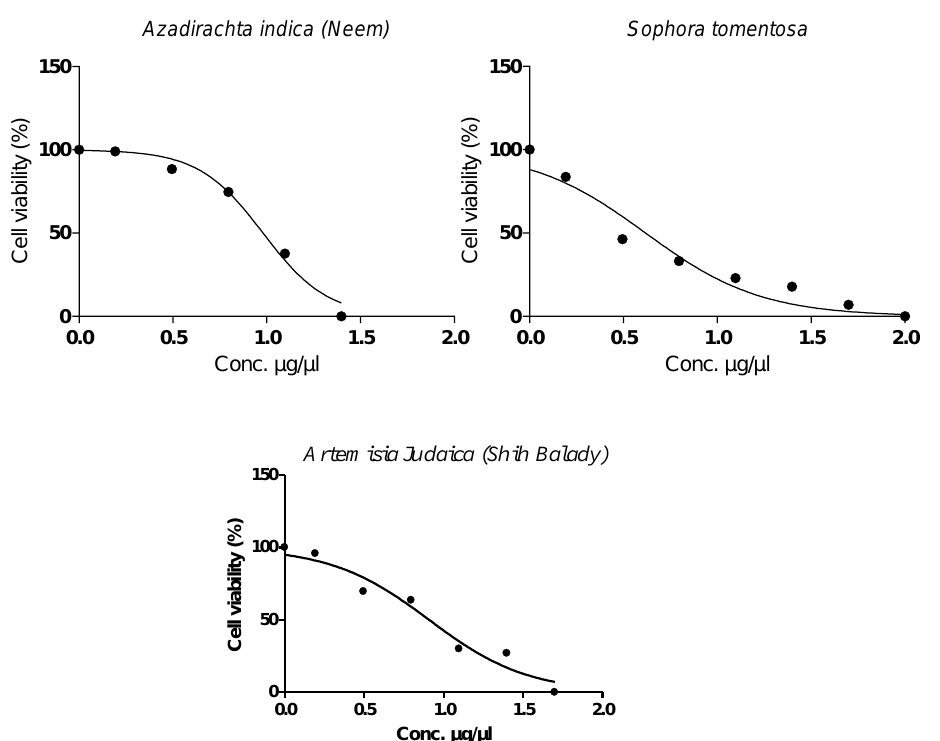
Figure 2. Cytotoxicity percentage and the concentration which exhibited 50% cytotoxic concentration (CC 50 ) of A. indica (neem), A. judaica (shih-Balady), and S. tomentosa extracts by MTT assay which was used with CC 50 of 22.52, 31.63, and 20.86 µg/mL, respectively. Table 1. Antiviral activity of three medicinal plants using plaque reduction assay against the MERS- CoV isolates (NRCE-HKU270 (Accession Number: KJ477103.2)).